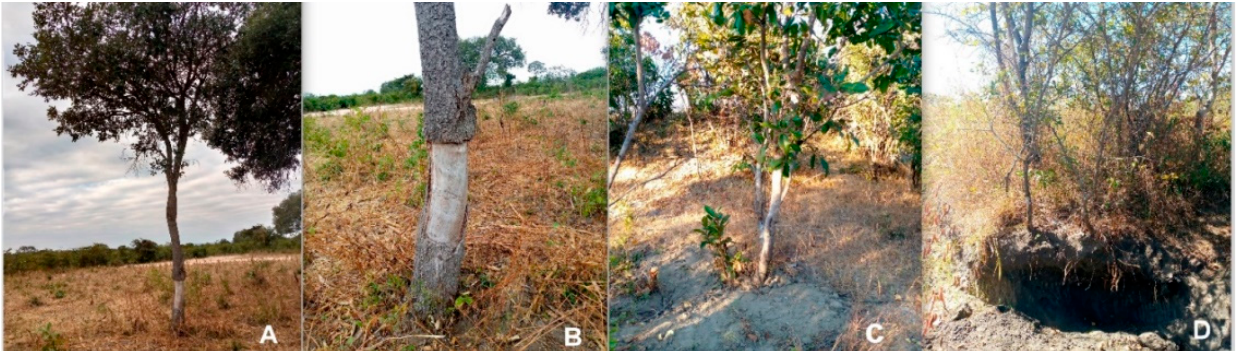
Figure 5. ( A , B ) Partial sustainable harvesting of stem bark as the stem is almost completely girdled or stripped of its bark; ( C ) sustainable harvesting of root bark; ( D ) unsustainable harvesting of root